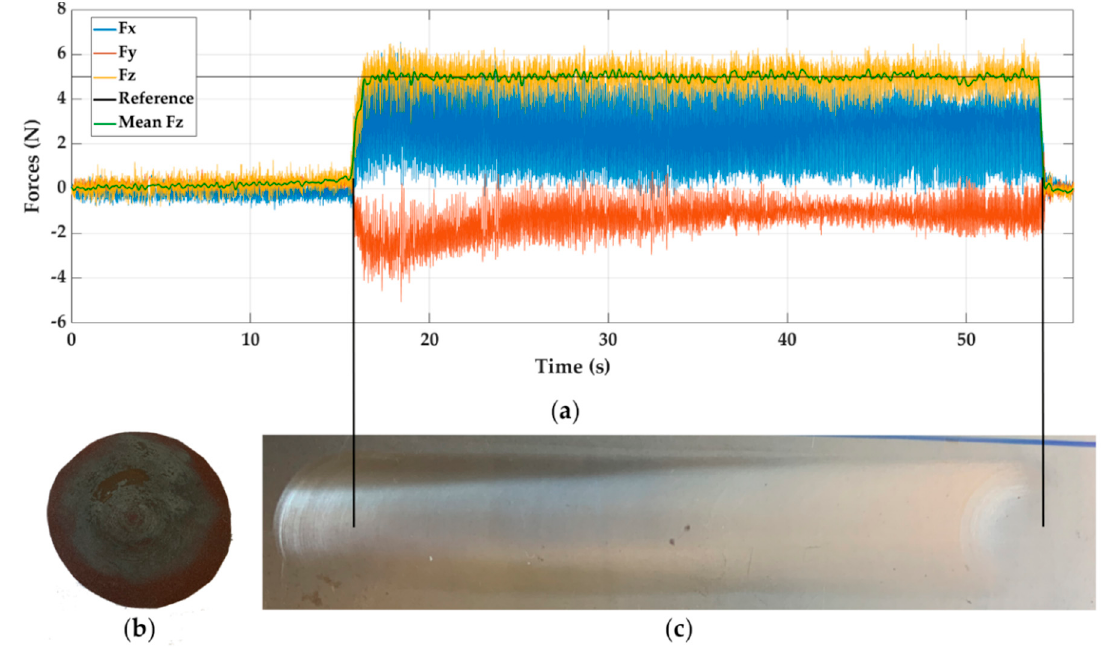
Figure 4. Experiment E6, sanding steel with P + FF control and reference force of 5 N. ( a ) Force response, ( b ) sandpaper aspect, and ( c ) visual surface finish.